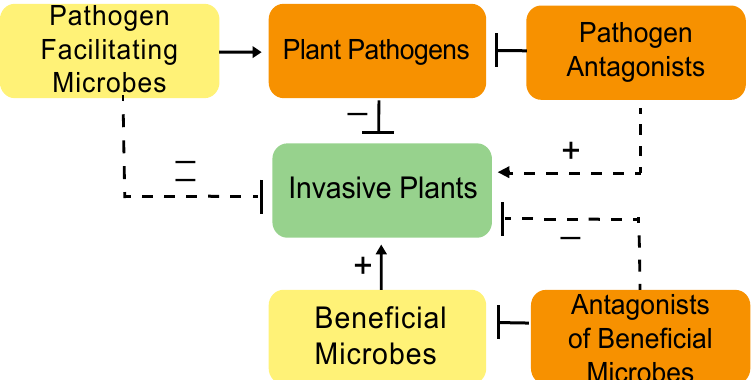
Figure 1. Diagrammatic representation of potential microbial interactions with invasive plants. Direct (solid lines) and indirect (dashed lines) impacts (positive [+] dignified with arrows and negative [ − ] signified with capped lines) on invasive plant fitness are indicated.